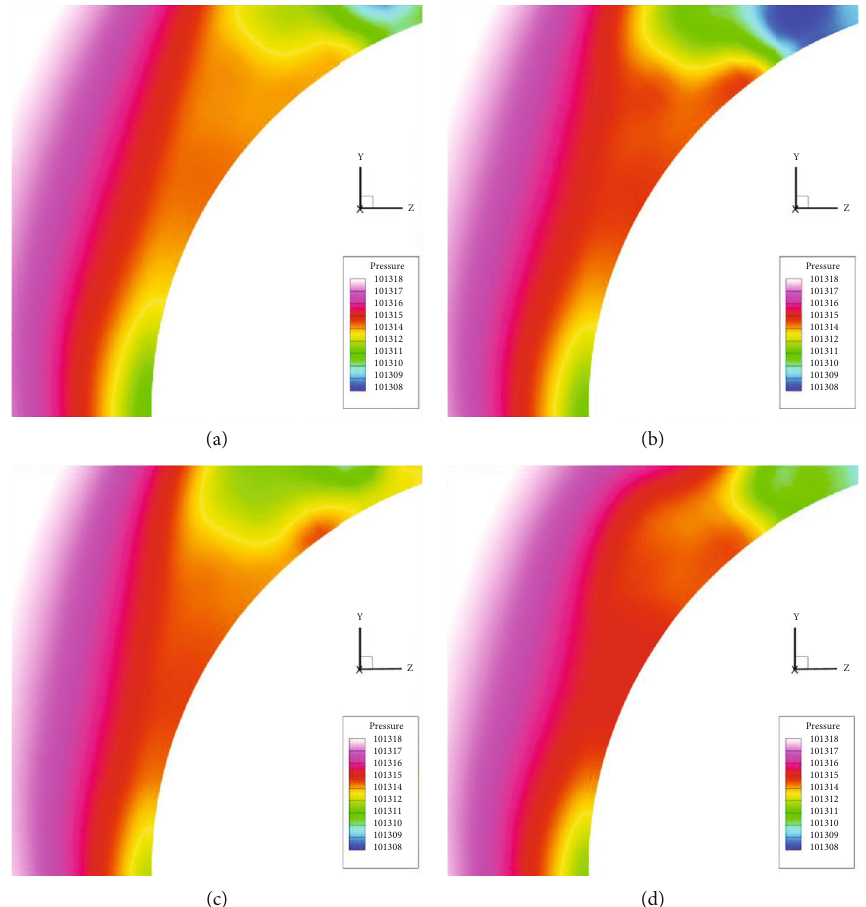
Figure 29: Comparison of closed-wall pressure with di ff erent roughness values at cross-section 3: (a) Model 1, (b) Model 2, (c) Model 3, and (d) Model